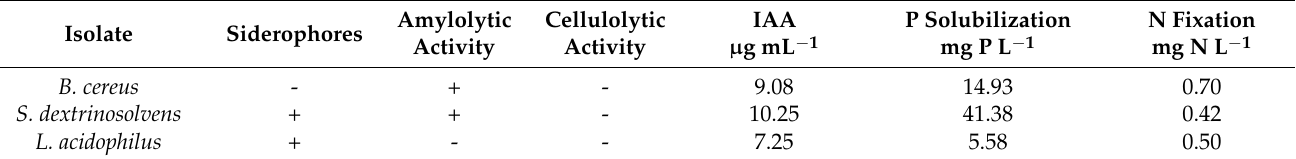
Table 1. The presence of siderophores, amylolytic and cellulolytic activities, IAA, phosphorus solubilization, and nitrogen fixation were shown by the bacteria B. cereus , S. dextrinosolvens , and L. acidophilus . The values were measured by Santos et al. (2020)